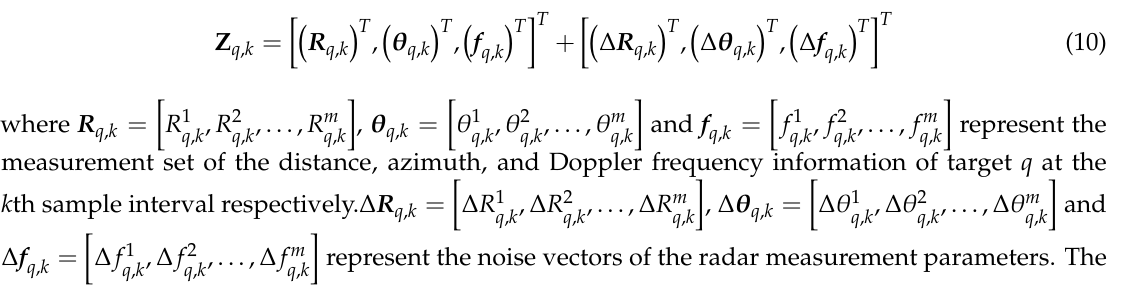
represent the and